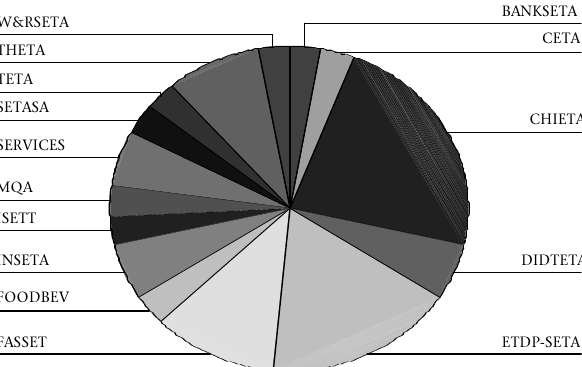
Figure 1: Analysis of questionnaires received from SETAs